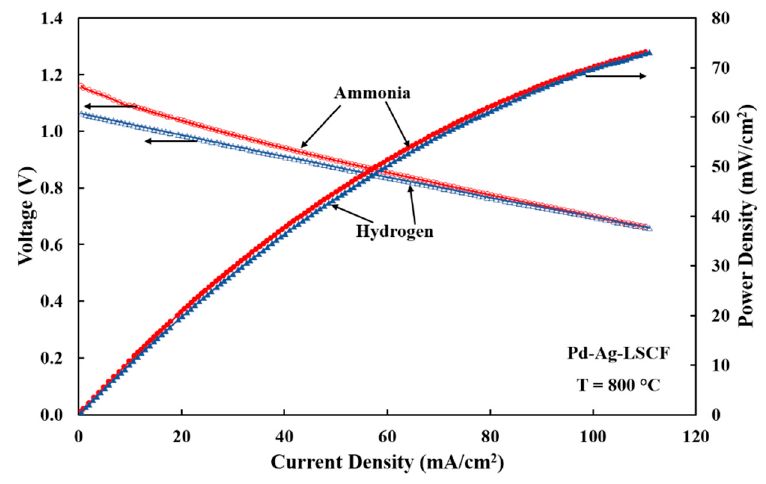
Figure 11. V-I-P for Pd-Ag-LSCF//YSZ//GDC/LSCF cell with hydrogen (hydrogen = 75 mL/min, air = 75 mL/min) and ammonia fuels (ammonia = 50 mL/min, air = 75 mL/min) °C.